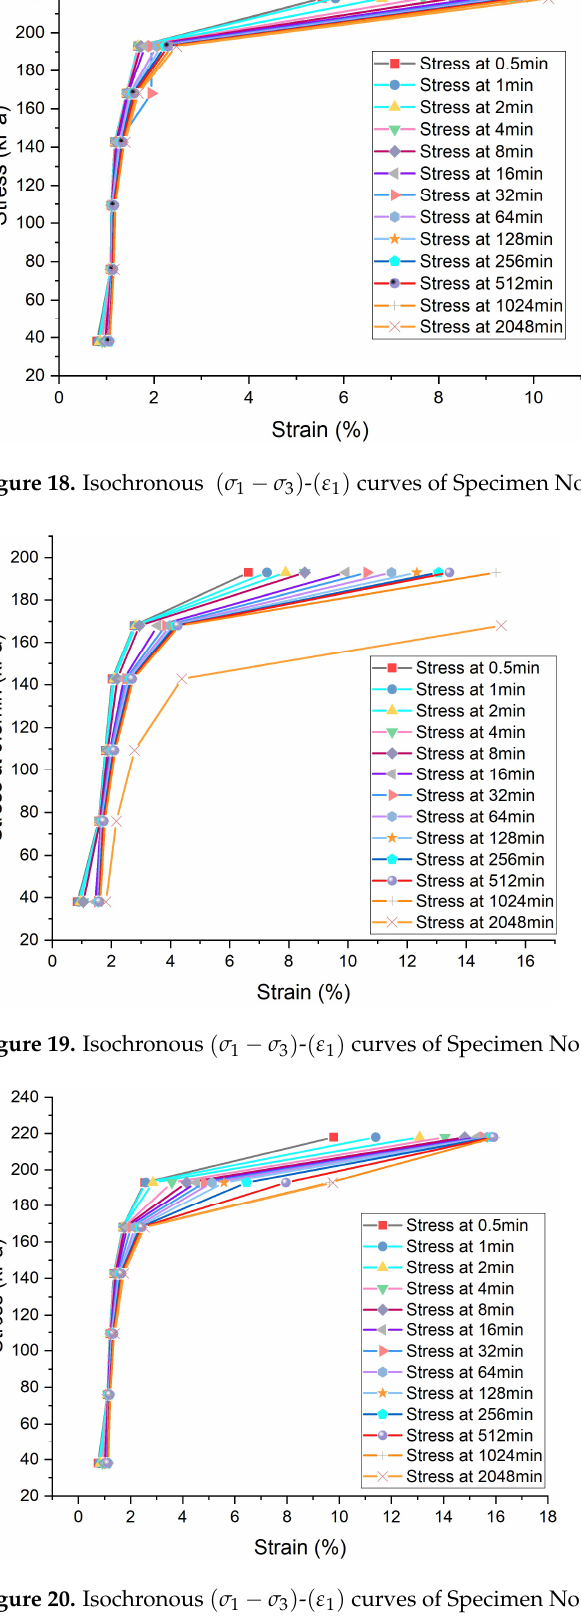
Figure 20. Isochronous (𝜎 (cid:2869) − 𝜎 (cid:2871) ) - (𝜀 (cid:2869) ) curves of Specimen No. 15, 7 FTHs.